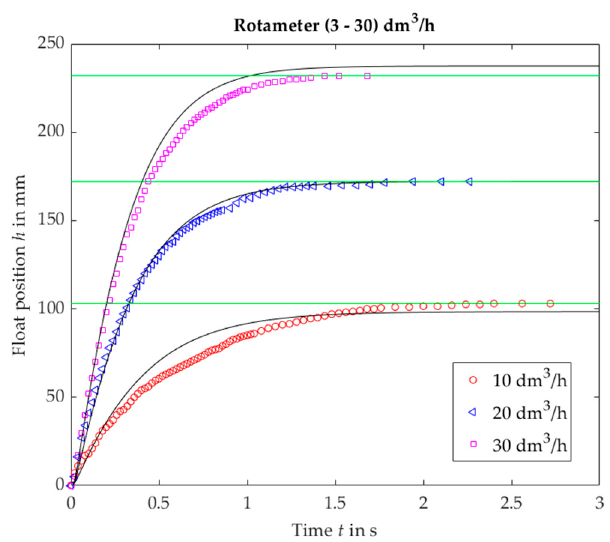
Figure 5. Rotameter no. 1, plumb bob. Float position h vs. time t for a step response, experimental (black solid lines) and calculated (markers).